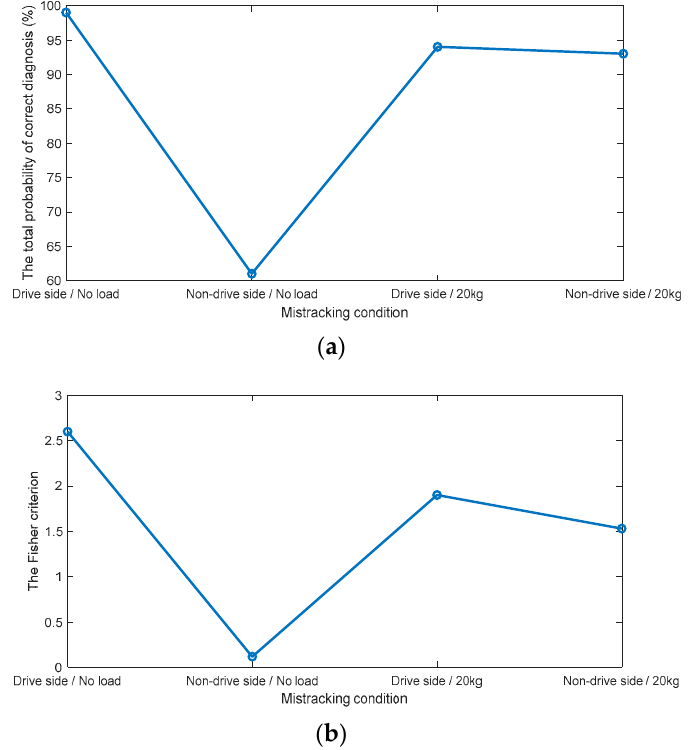
Figure 9. ( a ) The total probabilities of correct diagnosis (%), provided by the tricoherence ( b ) The Fisher criteria for the tricoherence.